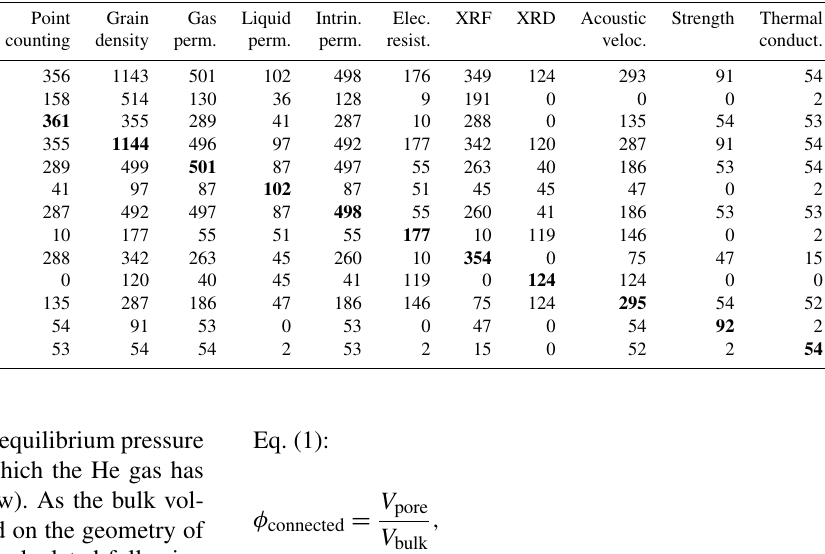
Table 4. Number of samples with both petrophysical and mineralogical data for different properties in the database. Bold text indicates the number of samples analyzed for a single property. XRF denotes X-ray fluorescence for bulk whole-rock geochemistry, and XRD denotes X-ray diffraction for quantitative mineralogical